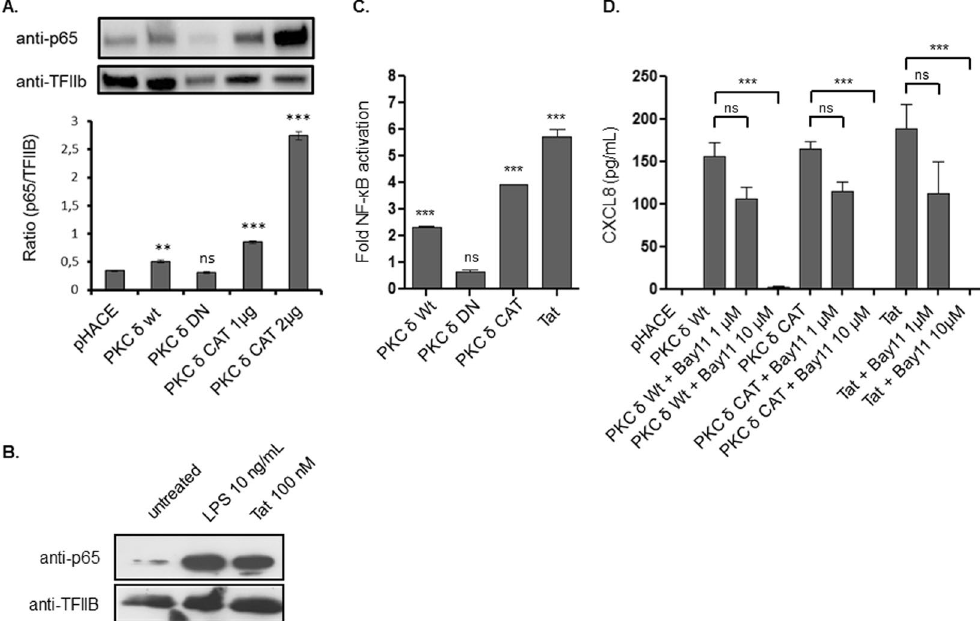
Figure 6. PKC- δ induces CXCL8 production via NF- κ B pathway. ( A ) HEK cells (10 6 cells/well) were transfected with 1 µ g of plasmid pHACE control, or encoding for PKC- δ Wt or DN, or 1 to 2 µ g of PKC- δ CAT. After 24 hours, cells were lysed and nuclear and cytoplasmic fractions were prepared. The translocation of NF- κ B was monitored by analyzing p65 subunit of NF- κ B in the nuclear fraction of the cells. Detection of the transcription factor TFIIB was used as a loading control. Quantification of the band obtained from 3 independent experiments was performed using ImageJ software. Data represent NF- κ B nuclear expression normalized to TFIIB. ( B ) HEK-TLR4-CD14-MD2 cell lines (2 × 10 6 cells) were left untreated or treated with Tat (100 nM) or LPS (10 ng/ml). After 60 min, cells were lysed and nuclear extracts were analysed by SDS- PAGE and western blot using anti-p65 or anti-TFIIb antibodies. ( C ) HEK-Blue ™ TLR4 cells (10 6 cells) were transfected with 0.5 µ g of plasmids encoding for of PKC- δ Wt, CAT, or DN for 48 h or treated with Tat protein (10 nM) for 24 h. SEAP activity was quantified in cells supernatant using colorimetric assay. Data represents fold NF-kB activation compared to empty plasmid “pHACE” transfected cells. ( D ) HEK TLR4 cells (10 6 cells) were pretreated with 1 or 10 µ M of NF- κ B inhibitor (Bay11-7280) 24 hours before transfection with 0.5 µ g of PKC- δ Wt or CAT plasmids, or 1 hour before Tat treatment (10 nM). After 24 hours of incubation cell supernatants were collected and CXCL8 production was quantified by ELISA. Statistical significance comparing different group were analysed with one-way ANOVA followed with a Bonferroni post tests and are denoted with ns for non-significant. The data are compared to negative pHACE control, otherwise the comparison is indicated by a black line above the